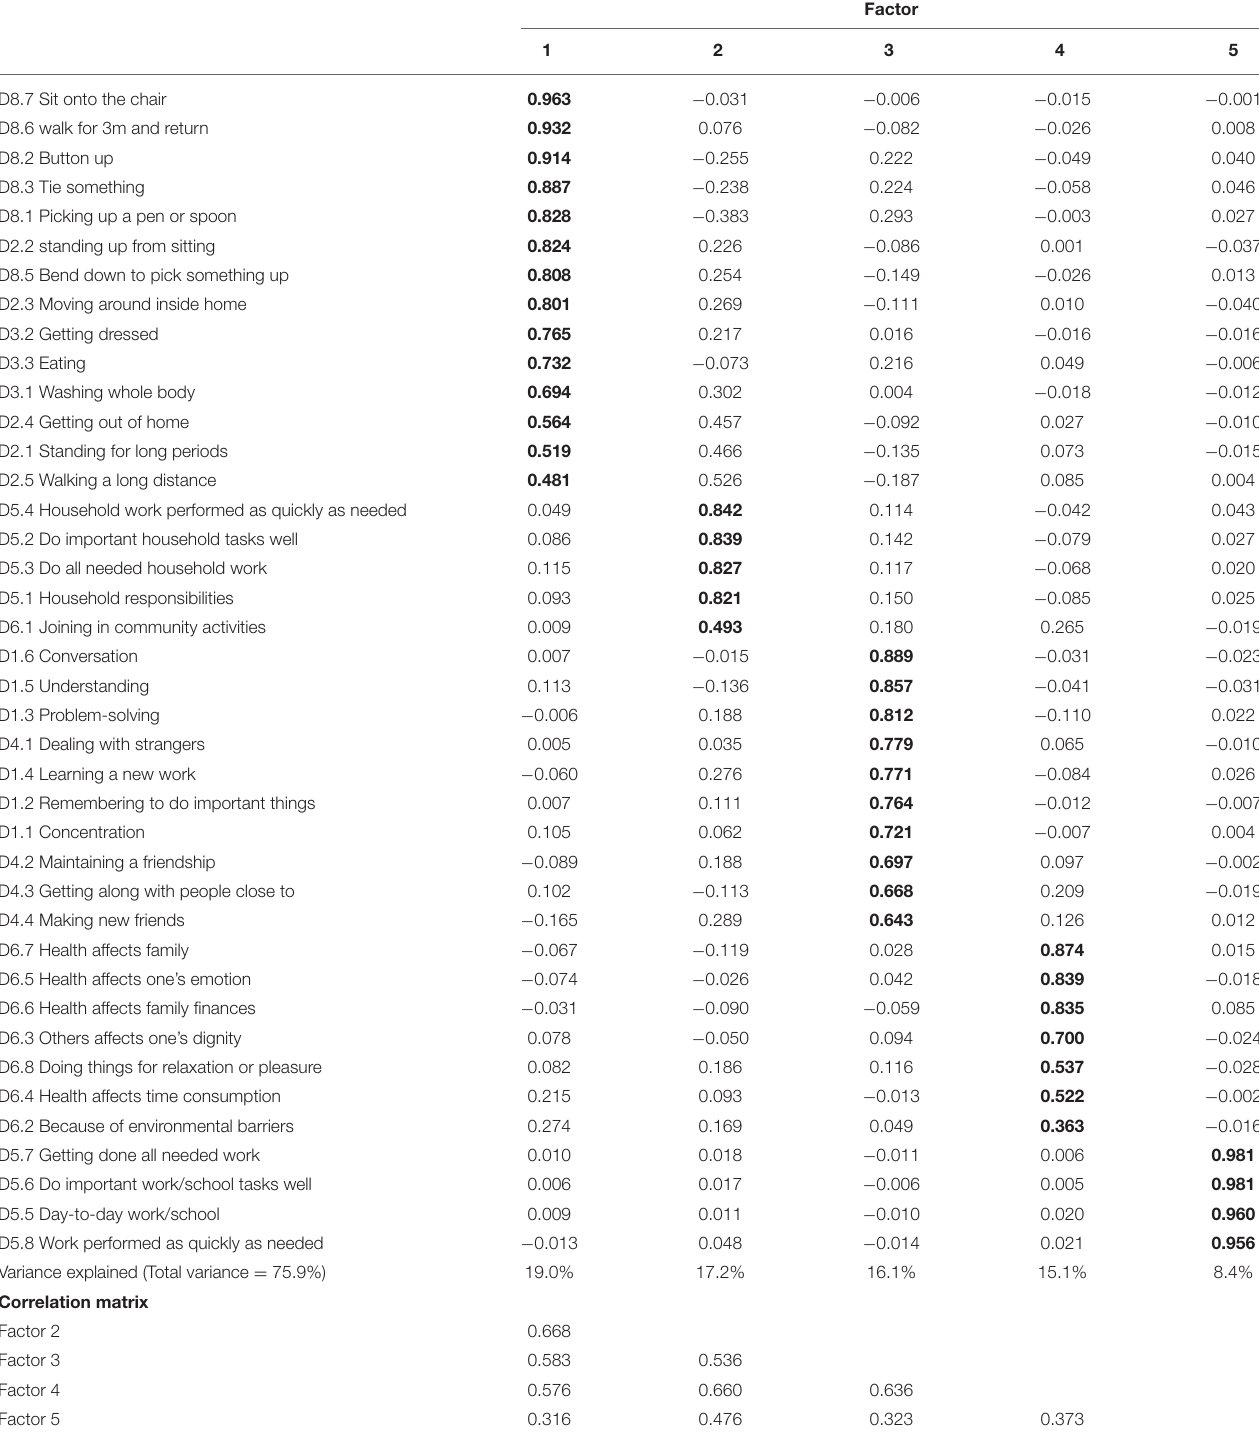
TABLE 3 | Factor loading of the capability dimension of the FUNDES-Adult by exploratory factor analysis ( n = 8730).